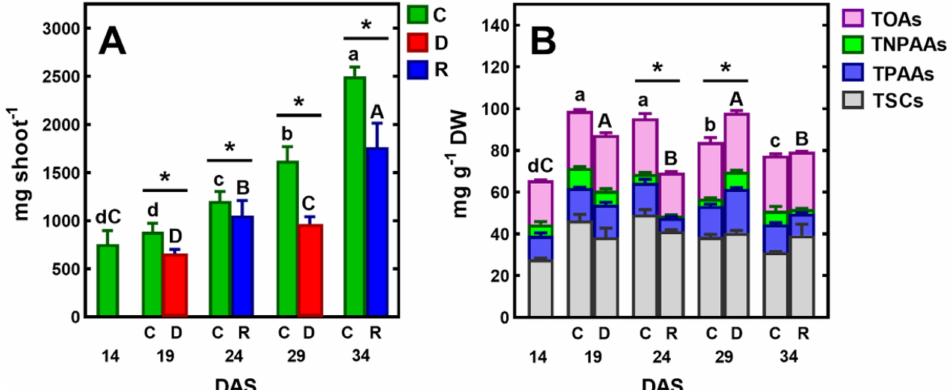
Figure 2. Changes in the fresh weight (FW) of the pea shoot ( A ) and the concentration of total identified polar metabolites (TIPMs), including major fractions ( B ): soluble carbohydrates (TSCs), protein amino acids (TPAAs), non-protein amino acids (TNPAAs) and organic acids (TOAs) during plant’s vegetation at control conditions (C) or exposed to short-term soil droughts (D) and re-watering (R). Values are means ( n = 3) ± SD. The same letters above the bars indicate no statistically significant differences ( p < 0.05), based on ANOVA and the Tukey post-hoc test for control plants (a–d, 14–34 DAS) or plants before and after soil drought and followed by recovery ( A , B ) The significant differences between TIPMs in shoots after 5 days of drought or re-watering and TIPMs in control plants (from the same DAS) were marked with an asterisk, based on the Student t -test (*, p < 0.05).